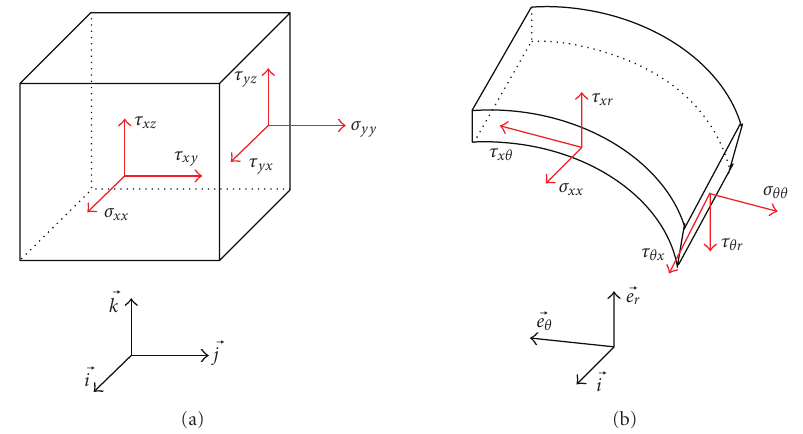
Figure 5: The stress components: (a) in the coordinate axes ( x , y , z ), (b) in the coordinate axes ( x , r , θ ).